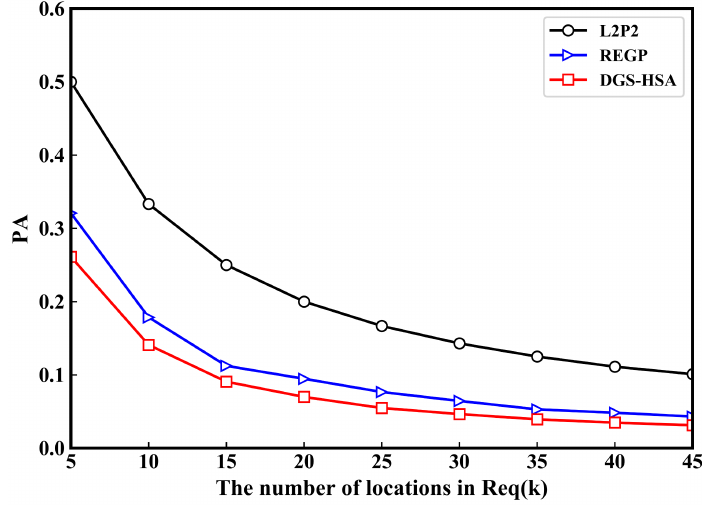
Figure 7. The probability P A that the user’s real organization is recognized varies with k